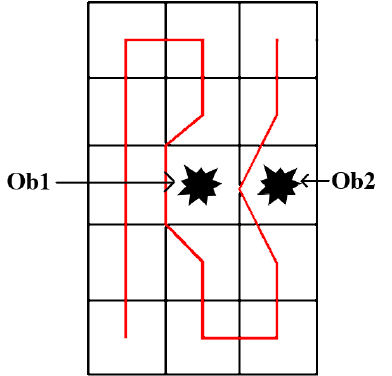
Figure 1. Different ways in avoiding obstacles.